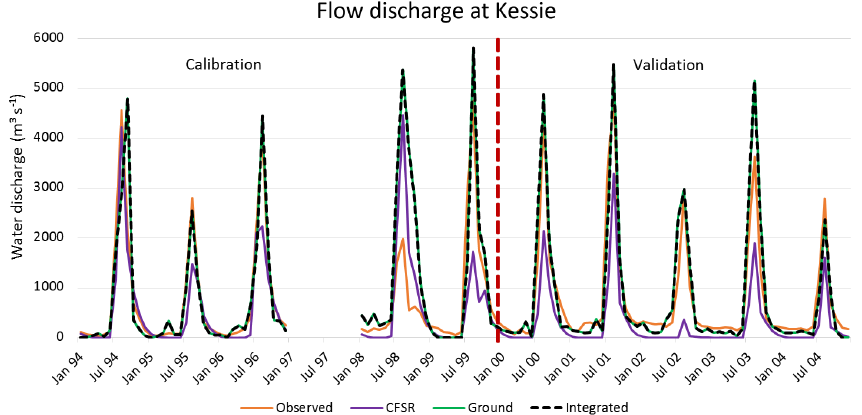
Figure 10. Calibration and validation of SWAT87 at Kessie. Calibration results achieved R 2 and NS values of integrated data: 0.77, 0.72; ground data: 0.77, 0.72; and CFSR data: 0.77, 0.37, respectively. Validations results achieved R 2 and NS values of integrated data: 0.78, 0.78; ground data: 0.80, 0.76; and CFSR data: 0.74, 0.37,